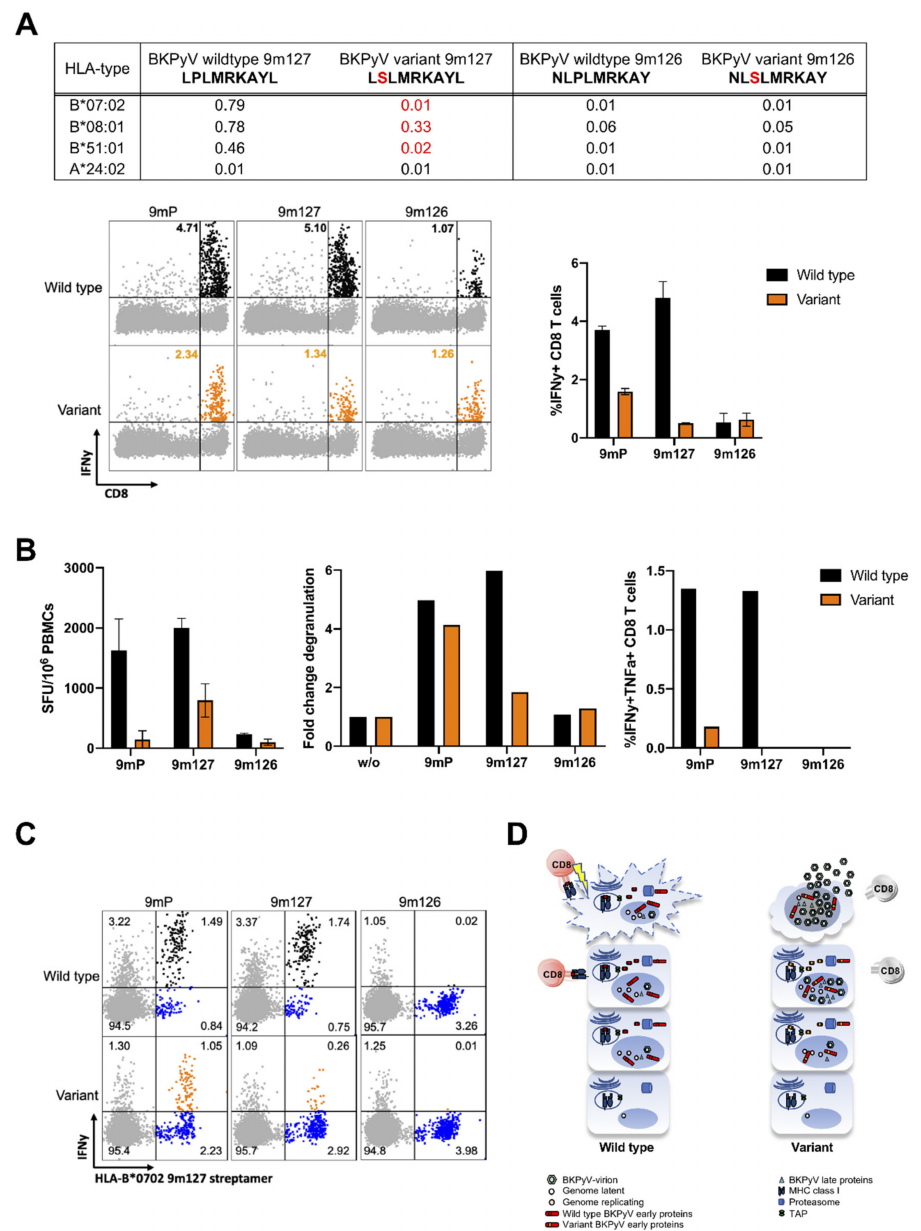
Figure 5. Comparing CD8 T-cell responses to wildtype and variant 9mer127. ( A ) Top: Predicted HLA-binding scores for wildtype 9mer127 and 9mer126 as well as their respective variants. Bottom: Representative flow-cytometry and intracellular cytokine staining (ic-FACS) for interferon-(IFN) γ (left) and cumulative results of two healthy BKPyV-IgG-seropositive HLA-B07-positive blood donors (right) showing the percentage of IFN γ + CD8 T-cells after re-challenge with wildtype (black) or variants peptides (orange). ( B ) BKPyV-CD8 T-cell function was independently evaluated for IFN γ by 9mer-ELISpot (left); or for CD107a + IFN γ + CD8 T-cell degranulation responses (middle); or by ic-FACS for polyfunctional TNF α + IFN γ + CD8 T-cell responses (right). ( C ) HLA-streptamer staining of CD8 T-cells was performed using PE-labelled streptactin with HLA-B*0702 molecules bearing wildtype 9m127 peptide as described [37,40], comparing response to wildtype or variant peptides. ( D ) Model